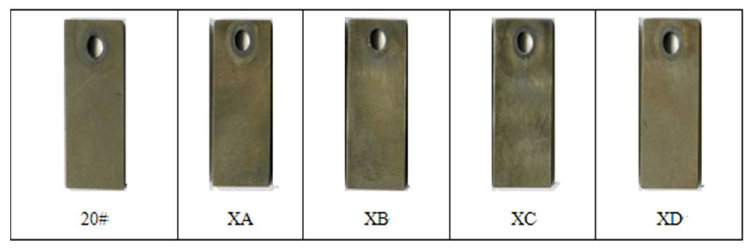
Figure 13. Morphology of coupons after the experiment.